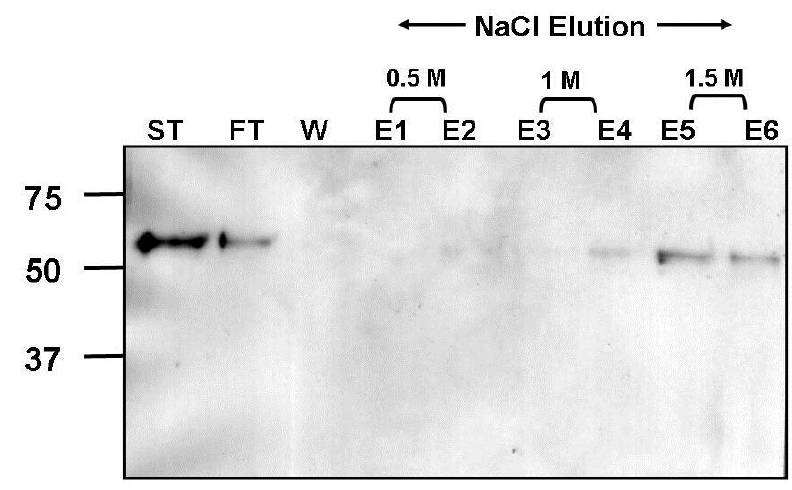
Figure 7. Heparin agarose affinity chromotography of recombinant soluble hMPV-F protein. Start material (ST), flow through (FT), wash (W) and elution (E) fractions, with 0.5M NaCl (E1 & E2), 1M NaCl (E3 & E4) and 1.5M NaCl (E5 & E6), were analysed by 10% SDS-PAGE under reducing conditions and western blot analysis using anti-hMPV F antibody. Molecular weight markers are shown in